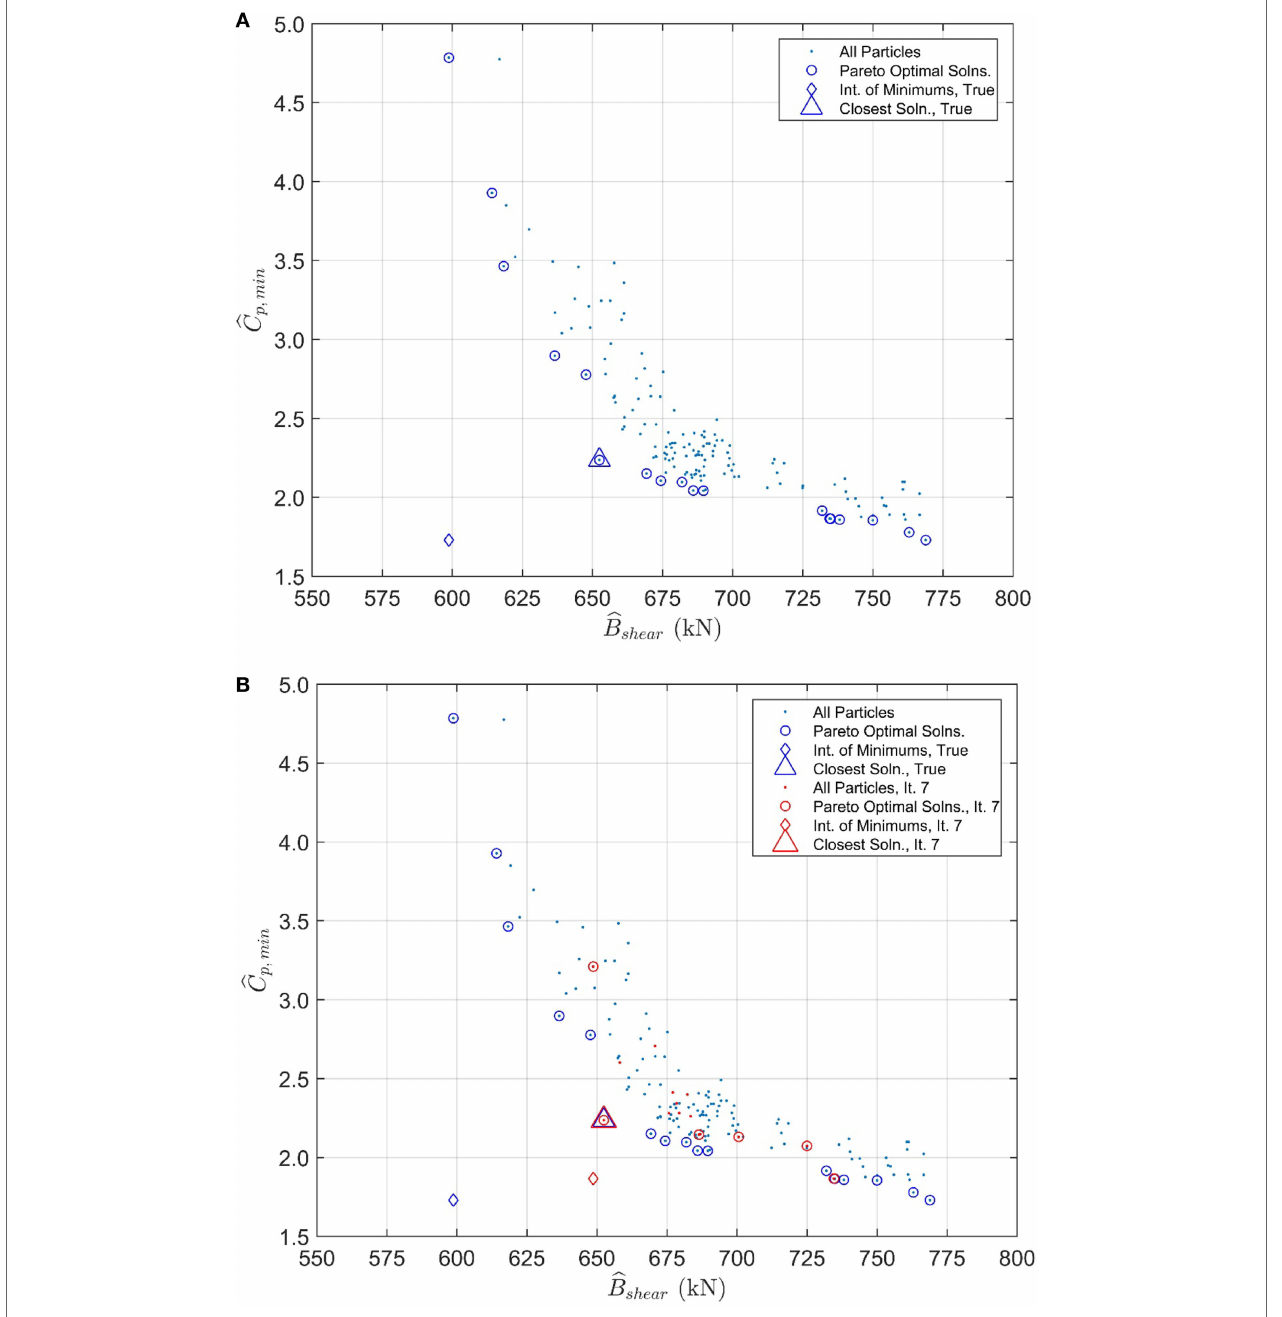
FIGURE 15 | (A) Pareto front curve considering all iterations and (B) highlighting the iteration of global best cost (iteration 7).